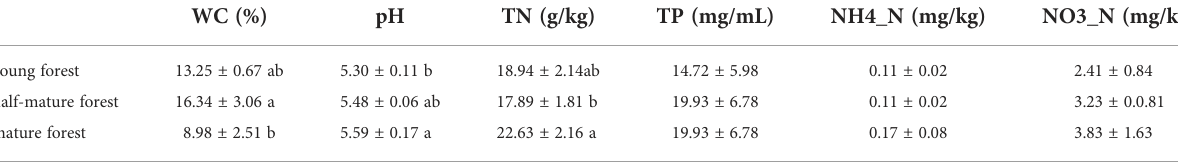
Different letters in the same column indicate signi fi cant differences (p <